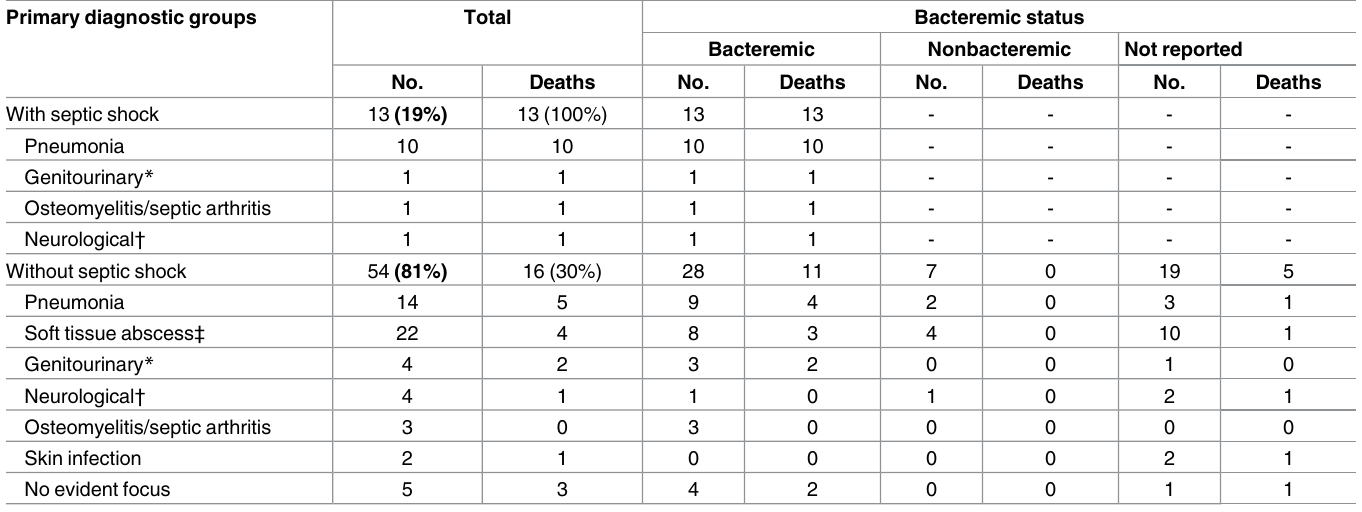
* Genitourinary with septic shock: prostate abscess (n = 1); without septic shock: prostate abscess (n = 2), perinephric abscess (n = 1) and epididymo- orchitis (n =